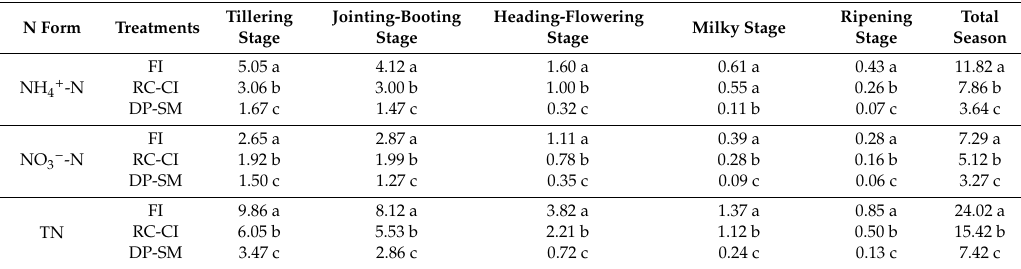
Table 4. The amount of nitrogen leaching losses during di ff erent rice growth stages (Addition of 2017 and 2018, kg /